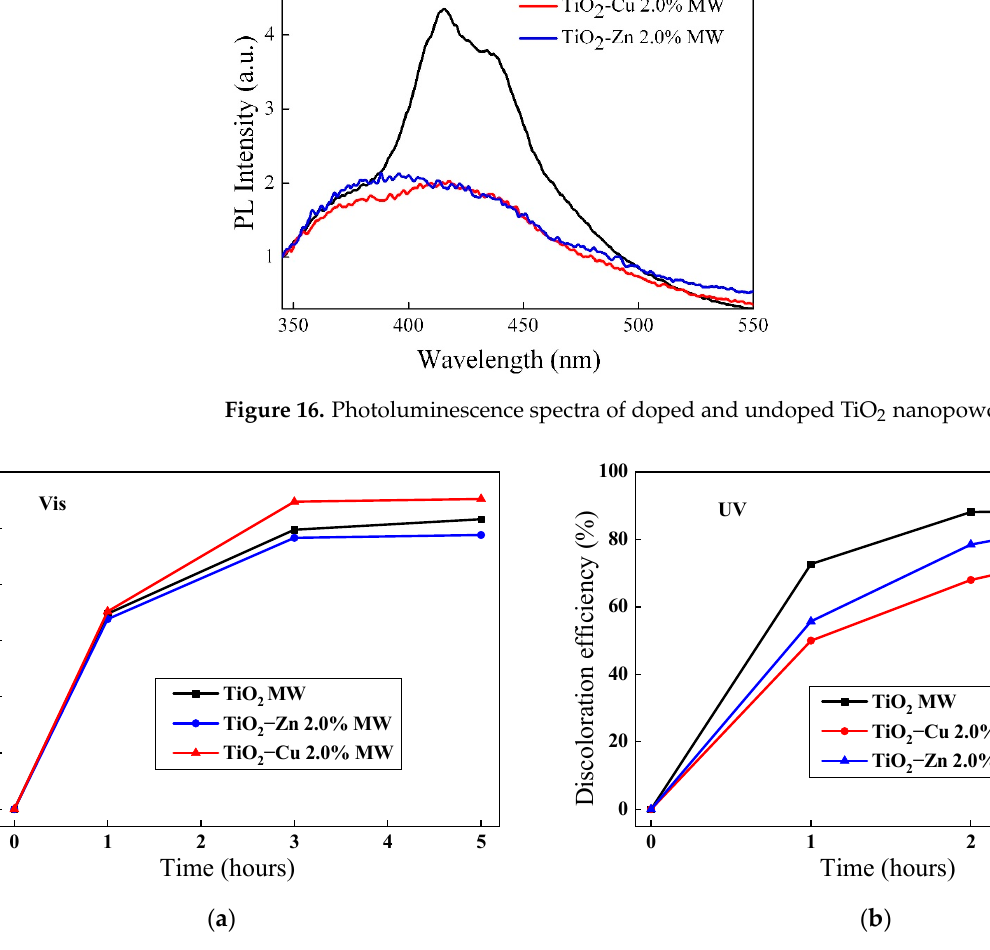
Figure 17. Photocatalytic activity of the samples under ( a ) visible- and ( b ) UV-light irradiation.